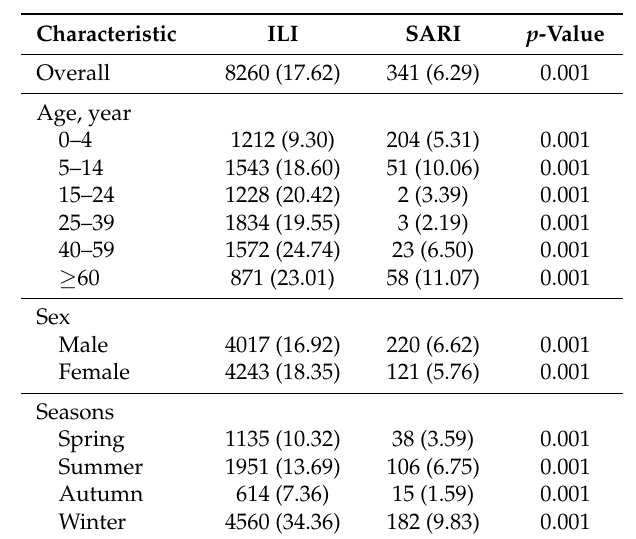
Figure 3. The influenza virus detection rate among the sampled ILI and SARI cases by age group in Zhejiang Province, China, March 2011–June 2015 (ILI = Influenza-like illness; SAIR = severe acute Table 2. Number (and rate) of samples tested positively for influenza virus type among influenza-like illness (ILI) and severe acute respiratory illness (SARI) cases, during March 2011–June 2015.